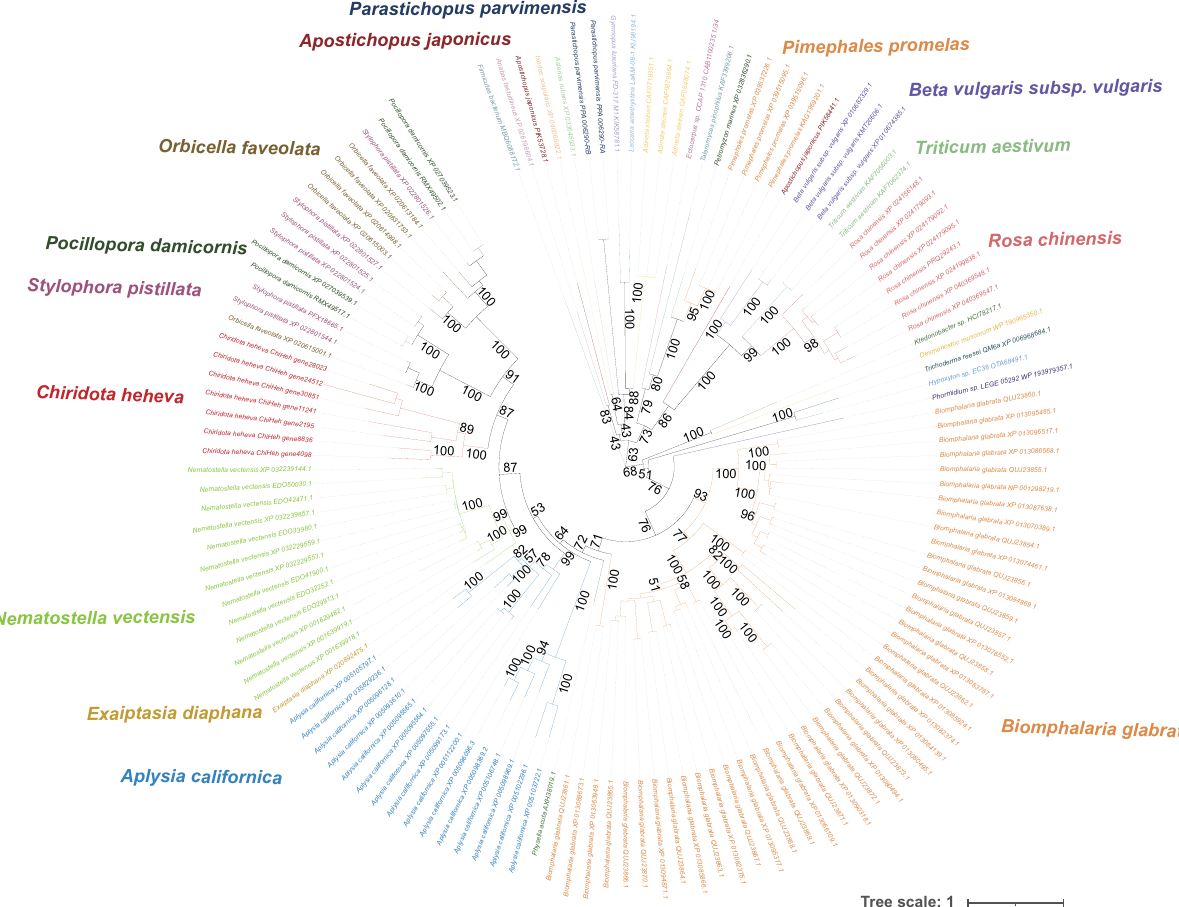
Fig. 5 Evolutionary relationship with aerolysin-like proteins (ALPs) from C. heheva and other species. The unrooted phylogenetic tree was reconstructed using a maximum-likelihood method. The values near the nodes are ultrafast bootstrap (UFBoot) values. ALPs from different types of species are highlighted by branches of different colors. The species name is shown near the corresponding lineage. ALPs from C. heheva do not cluster with ALPs from other echinoderms ( A. japonicus , P. parvimensis ), but with the ones from sea anemones ( N. vectensis , E. diaphana